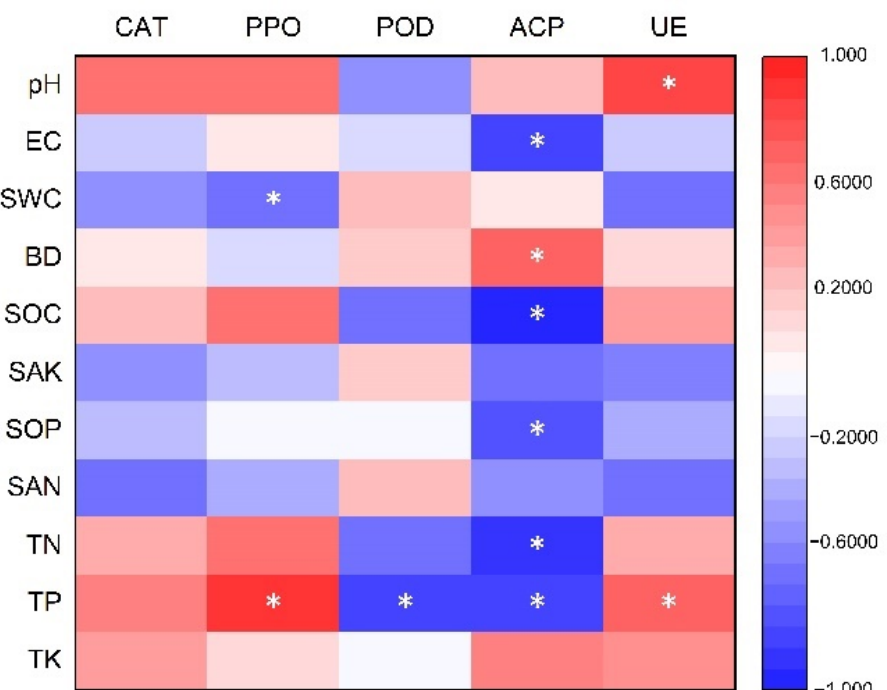
Figure 7. Relationship between soil environmental factors and soil enzyme activities. * Correlation is significant at the 0.05 level. Red indicates a positive correlation and blue indicates a negative correlation, and the darker the color, the stronger the correlation. Electrical conductivity (EC), soil